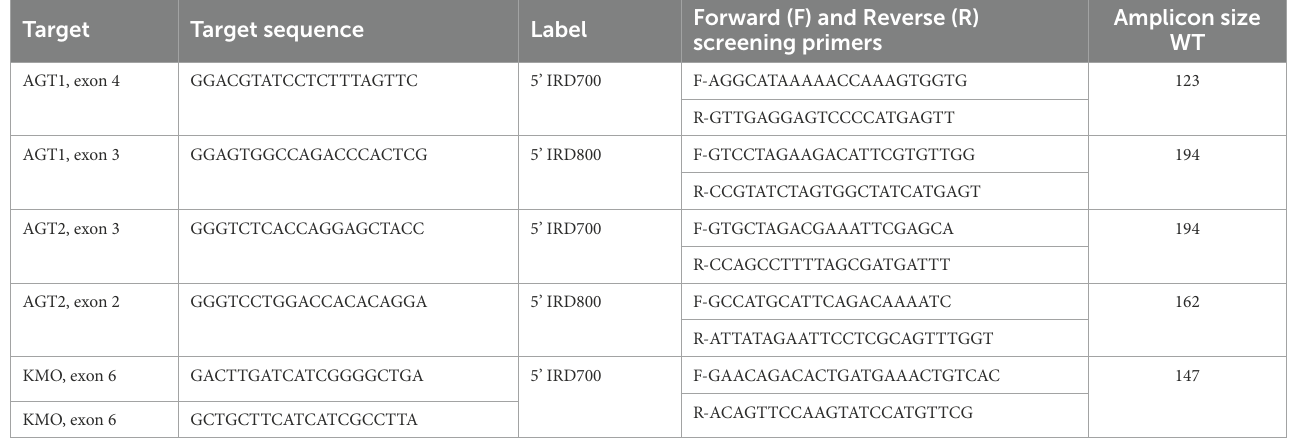
TABLE 1 Target and primer sequences for the different knockout target genes.